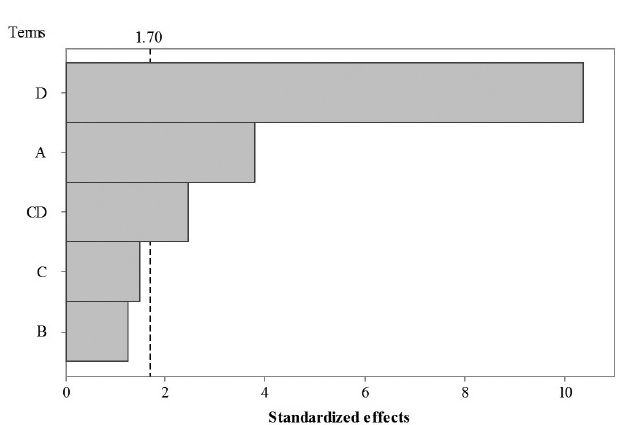
FIGURE 2 - Pareto chart for effects of time of dissolution (A), volume f dissolution media (B), pH of dissolution media (C), rotation speed (D), and the interaction of pH and rotation speed (CD) on the amount of acetaminophen dissolved.